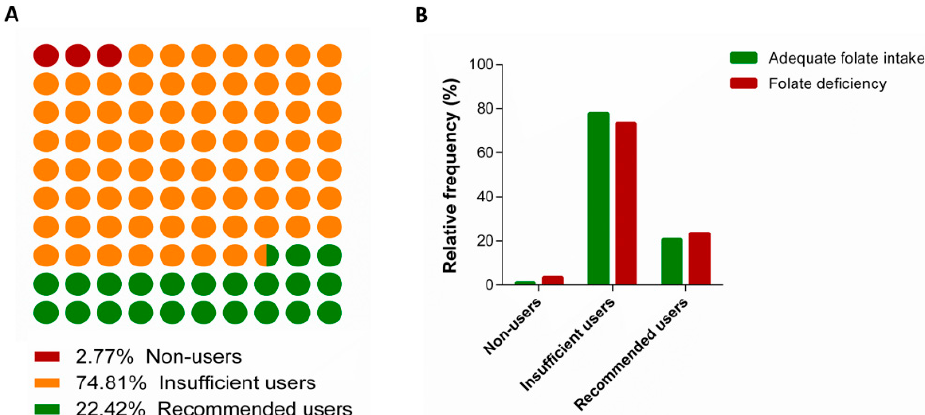
Figure 2. Use of folic acid supplements among pregnant women. ( A ) Panel A shows proportions of non-users, insufficient users and recommended users among the overall cohort. ( B ) Panel B shows the categories of folic acid supplement according to folate intake.